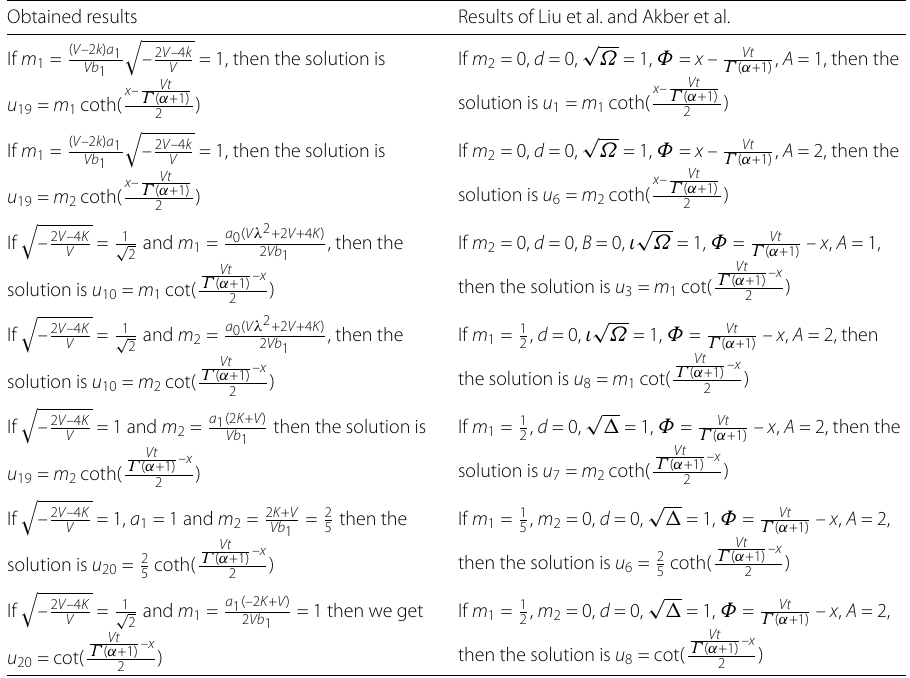
Table 1 Comparing the results of Akber et al. [26] and Liu et al. [22] with our results Obtained results Results of Liu et al. and Akber et al.